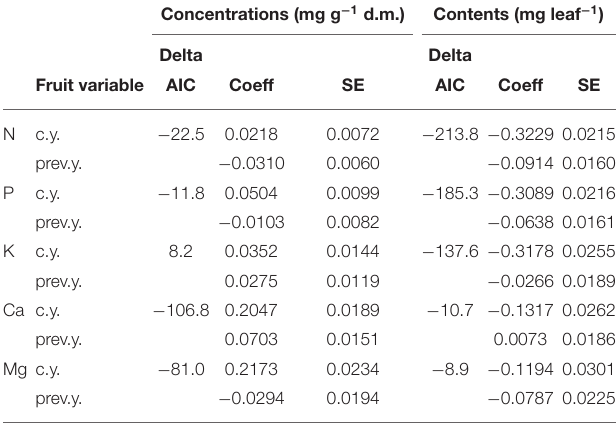
TABLE 4 | Regression coefficients for the correlation of nutrient concentrations (left part) and nutrient contents (right) with the fructification of the current year (line c.y.) and of the previous year (line prev.y.).